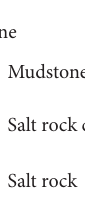
Figure 11: Cloud map of plastic zone distribution of single-cavern horizontal salt rock underground storage with different diameter-to- height ratios ( N � 1.5, 2.0, and 3.0) (20 a ). (a) N � 1.5; (b) N � 2.0; and (c) N � 3.0.